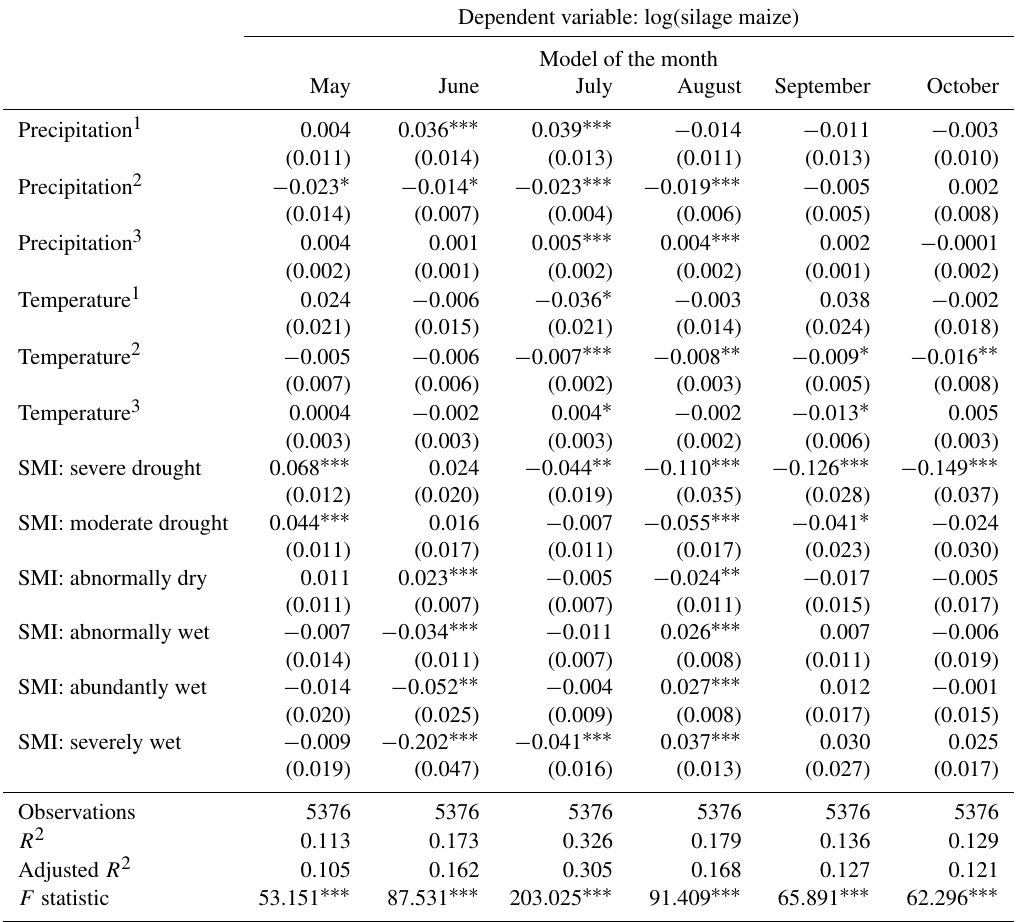
Table 4. Results of regression models employing precipitation and temperature to account for meteorology (both with polynomials of degree 3; superscripts denote the degree of individual polynomials) and a stepwise function of